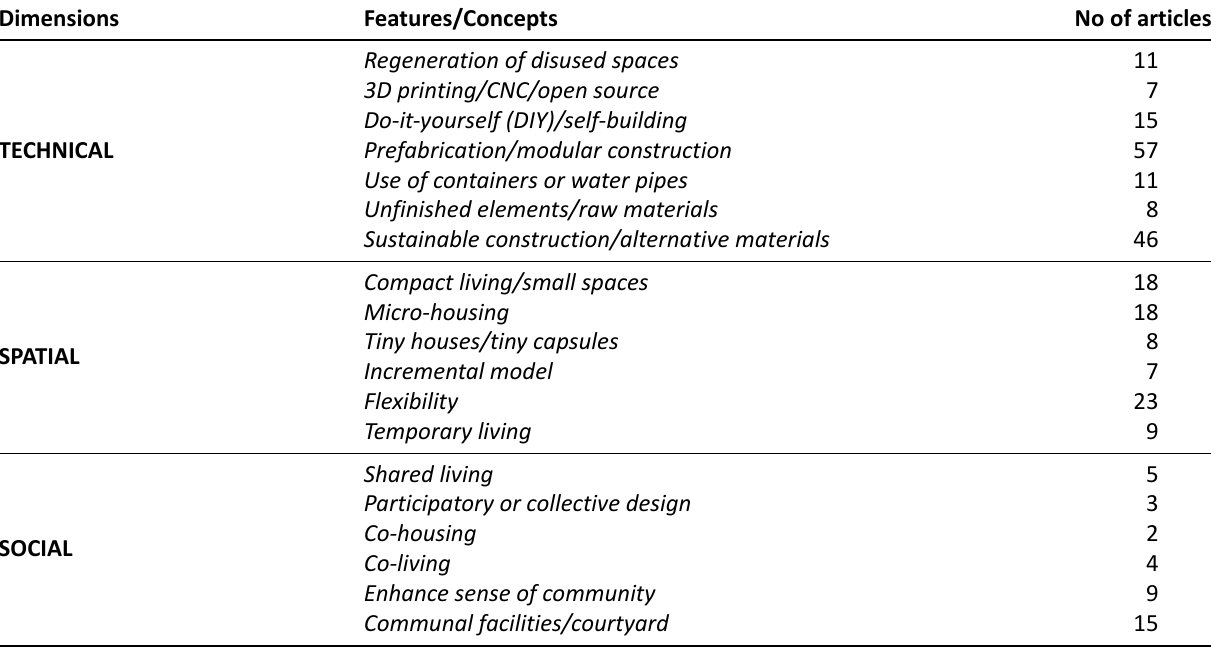
Table 1. Features and concepts related to current ‘affordable’ and ‘low-cost’ housing, scanned from the systematic litera- ture